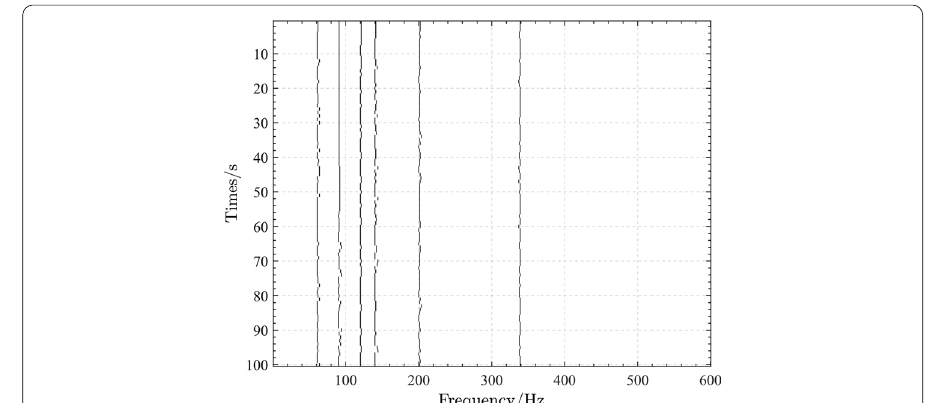
Fig. 17 Extraction results of optimal path algorithm for first set of sea-trial data